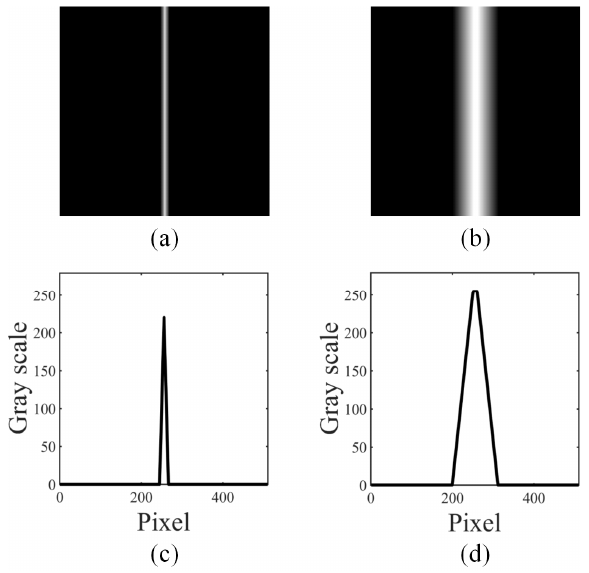
Figure 2. Impulse, roof edge images, and their corresponding grayscale change curves of pixels on a row: ( a ) impulse edge; ( b ) roof edge; ( c ) impulse edge grayscale change curve; ( d ) roof edge gray- scale change curve. change